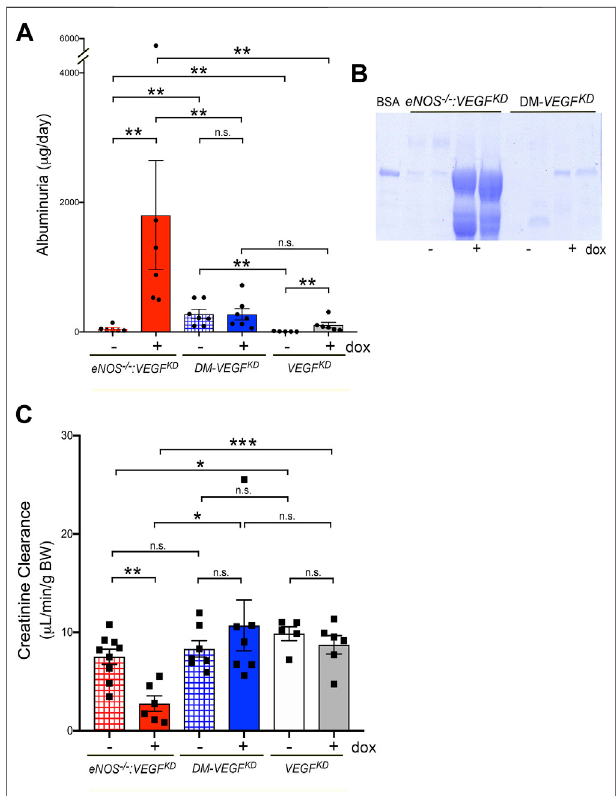
FIGURE 5 | Podocyte VEGF KD causes massive proteinuria and renal failure in eNOS − / − :VEGF KD mice. (A) Induction of VEGF KD in eNOS − / − :VEGF KD (+dox) mice (red bar) increases albuminuria ~30 fold higher than in control eNOS − / − :VEGF KD ( − dox) (**, p = 0.0022) but does not change albuminuria in diabetic mice (DM- VEGF KD + dox, blue bar) (n.s., p = 0.9015); VEGF KD causes mild albuminuria in non-diabetic mice ( VEGF KD + dox, gray bar) compared to controls ( VEGF KD − dox, white bar) (**, p = 0.0043), Mann-Whitney test. (B) SDS PAGE/Coomassie stain shows severe albuminuria in eNOS − / − :VEGF KD + dox and milder albuminuria in diabetic VEGF KD + dox mice; BSA = bovine serum albumin marker, urine volume loading was normalized to creatinine. (C) Creatinine clearance decreases upon VEGF KD induction in eNOS − / − :VEGF KD + dox mice (red bar) to ~1/3 of control eNOS − / − :VEGF KD − dox(***, p =0.0009),butisnotsigni fi cantlyaltered in diabetic mice (DM- VEGF KD − dox and + dox, hatched/blue bars) (n.s., p = 0.4114)or VEGF KD innon-diabeticmice( VEGF KD − doxand+dox,white/gray bars) (n.s., p = 0.359) with intact eNOS; induced eNOS − / − :VEGF KD (+dox) mice had signi fi cantly lower Creat Cl than diabetic VEGFKD + dox and non- diabetic VEGF KD + dox mice (*, p = 0.02 and ***, p = 0.0007, respectively).